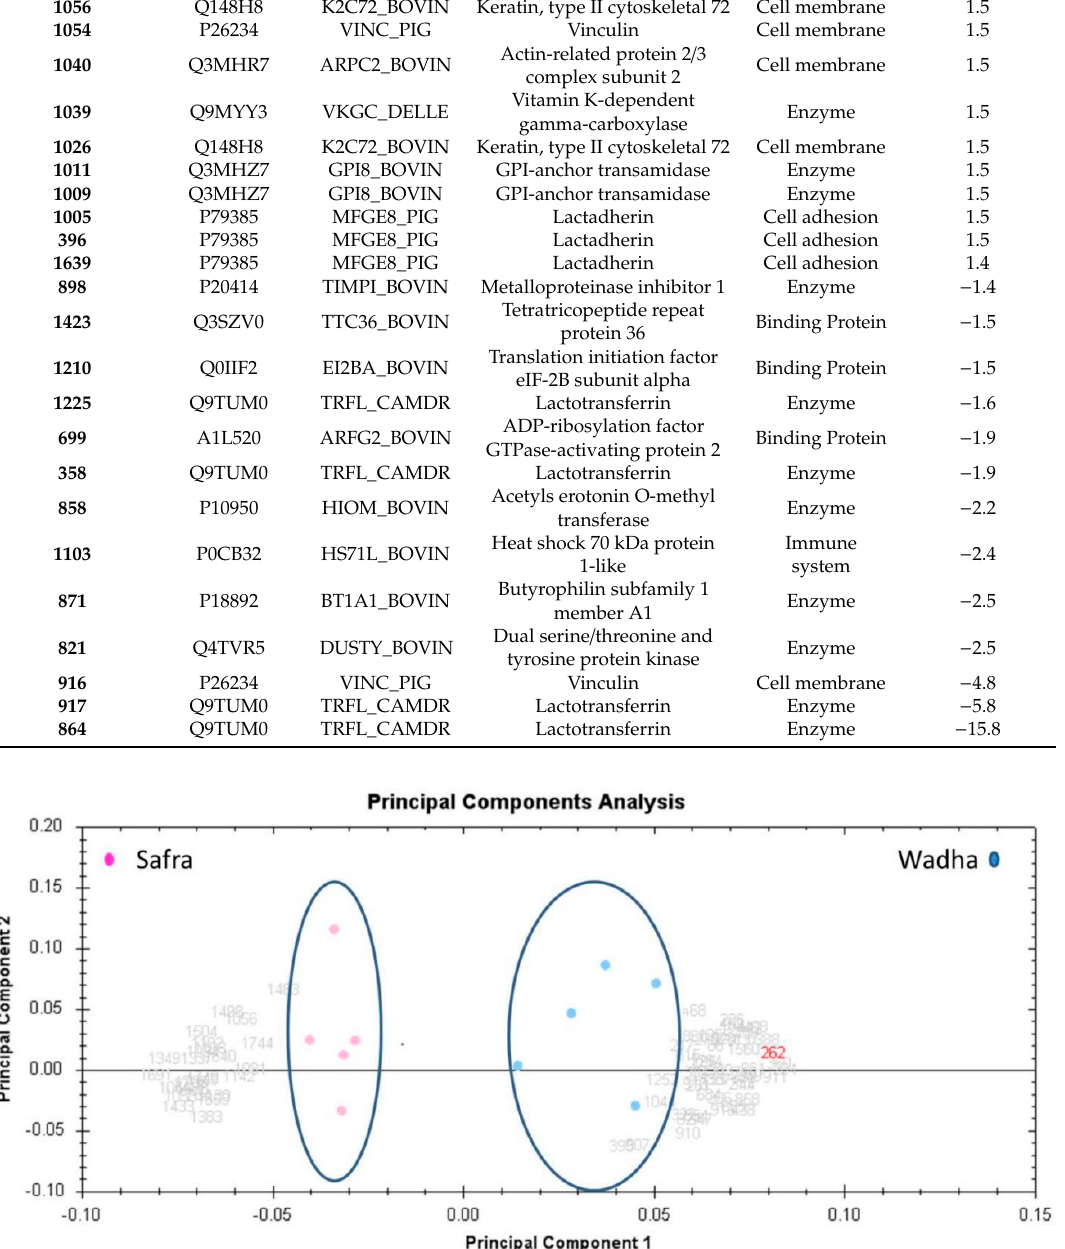
Figure 3. PCA plot of the two first principal components. Both together explained 75.15% of the selected spot’s variability. Colored dots ( n = 10) and numbers indicate the representation of gels ( n = 5 of Wadha and n = 5 of Safra) and spot proteins number ( n = 60), respectively.